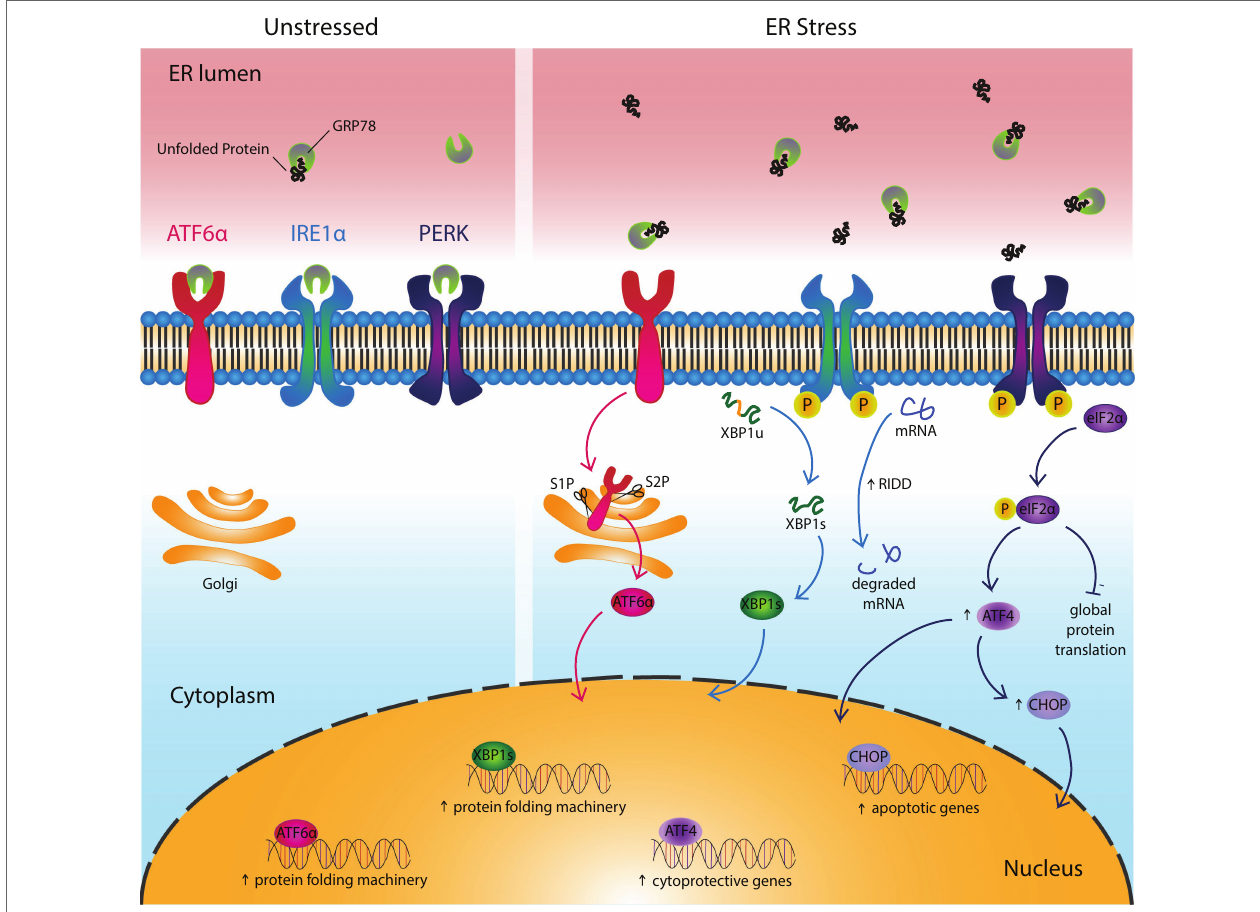
FIGURE 1 | Cells respond to ER stress via UPR activation. The UPR consists of three canonical receptors, activating transcription factor 6 α (ATF6 α ), inositol- requiring enzyme 1 α (IRE1 α ), and protein kinase R-like ER kinase (PERK). (Left) Under unstressed conditions, GRP78, the UPR ligand and chaperone, binds the UPR receptors to maintain them in their inactive state. (Right) In response to ER stress, GRP78 leaves the UPR receptors and assists in the folding of unfolded proteins, thereby activating the receptors. More specifically, ATF6 α translocates to the Golgi where it is cleaved by enzymes, site-1 protease and site-2 protease, before entering the nucleus as a transcription factor that upregulates genes involved in protein folding. IRE1 α undergoes autophosphorylation and activates its endoribonuclease, which splices unspliced XBP1(u) mRNA into spliced XBP1(s). XBP1s protein acts as a transcription factor that upregulates genes involved in protein folding. IRE1 α also reduces ER stress by splicing mRNAs into non-functional transcripts before they can be translated, a process called regulated IRE1- dependent decay. PERK autophosphorylates then phosphorylates eIF2 α , which inhibits protein translation, with the exception of ATF4-regulated genes like CHOP. ATF4 upregulates cytoprotective genes and in the case of chronic ER stress, it induces apoptosis via